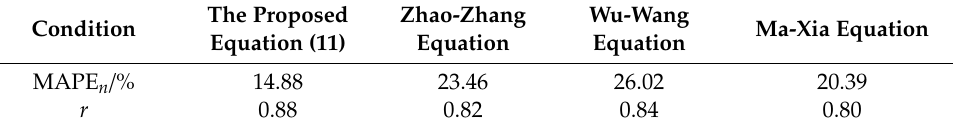
Table 2. Performance of different flow resistance equations using the validation data.